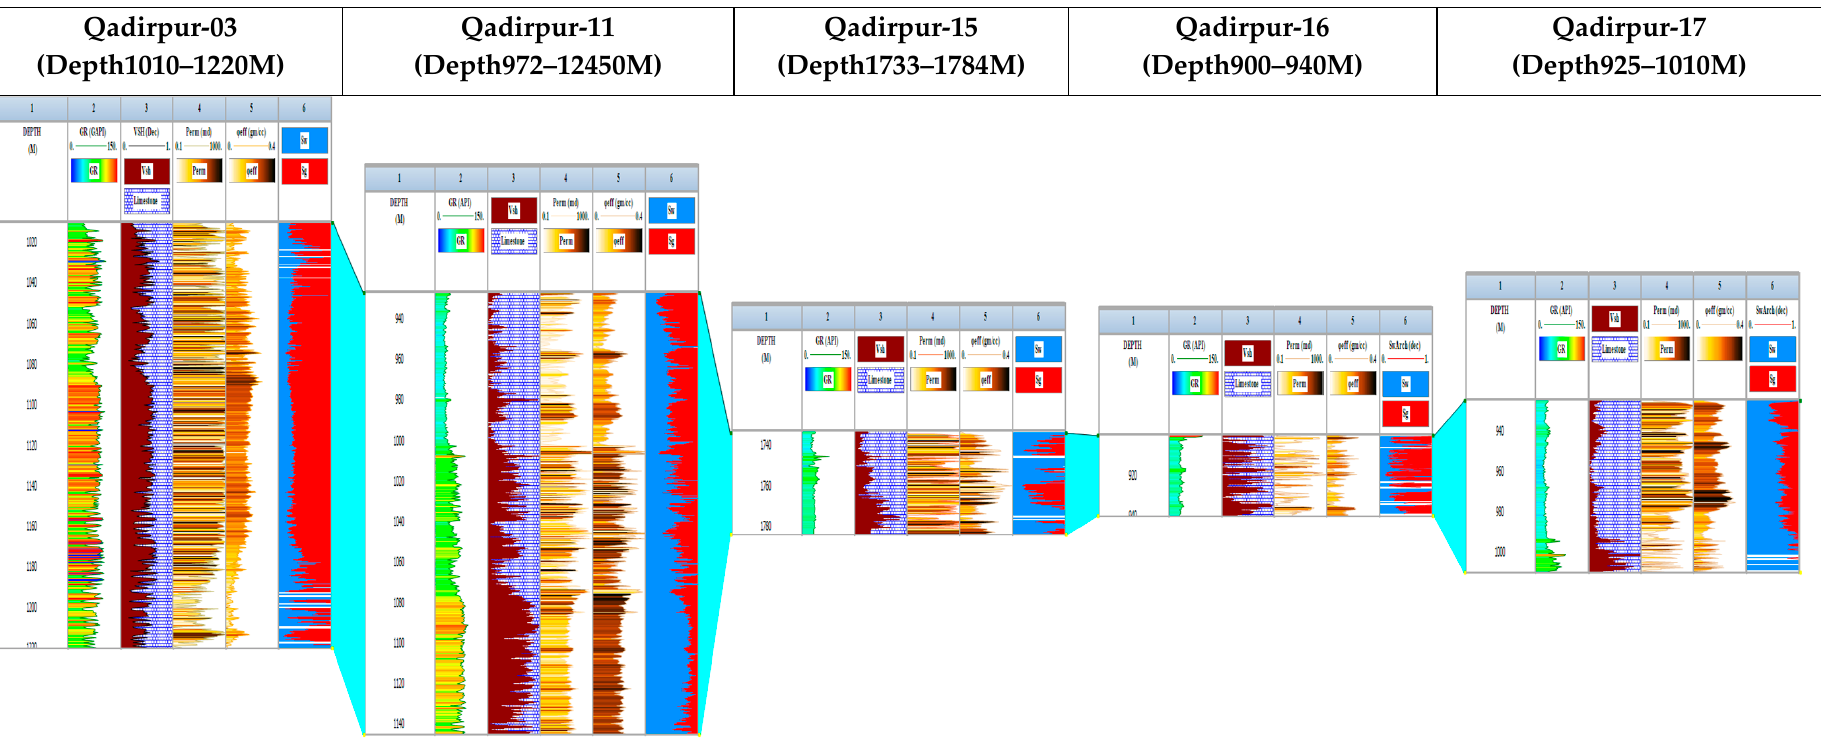
Figure 17. QGF well correlation.